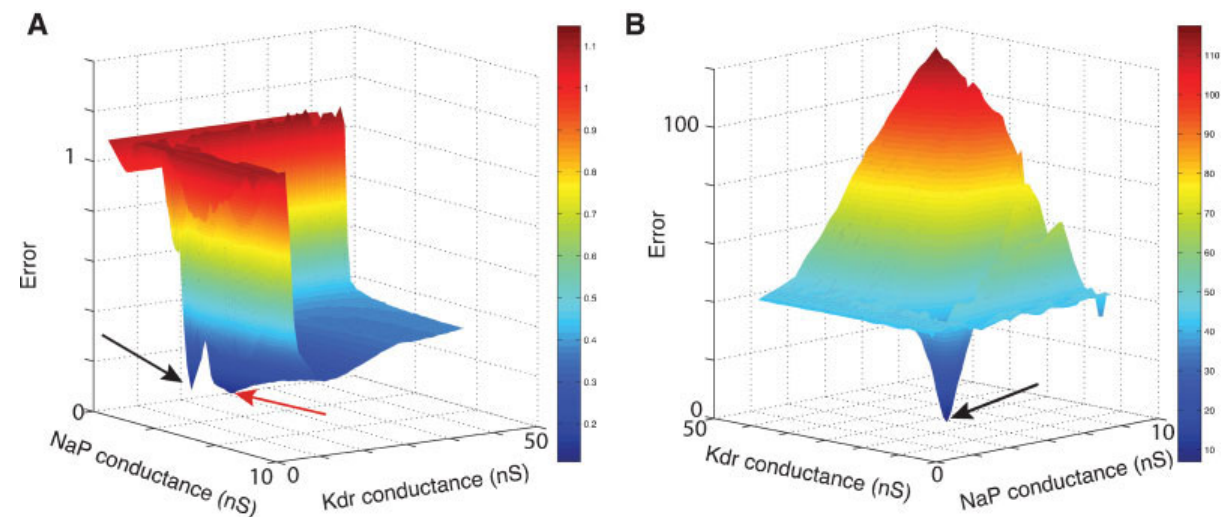
Figure 9. Error landscapes . 3D plots of error landscapes created by Mesh searches in the solution space of the pacemaker neuron model. ( A ) uses Equation (1) to calculate the error values; ( B ) uses Equation (2). Remark that the deep blue region in panel A has become dark red in panel B . The view angle of both plots is chosen differently to allow a better view of the 3D landscapes. The black arrows indicate the location of the optimal solution. The red arrow points to the position of a local minimum that created problems for the ES algorithm.